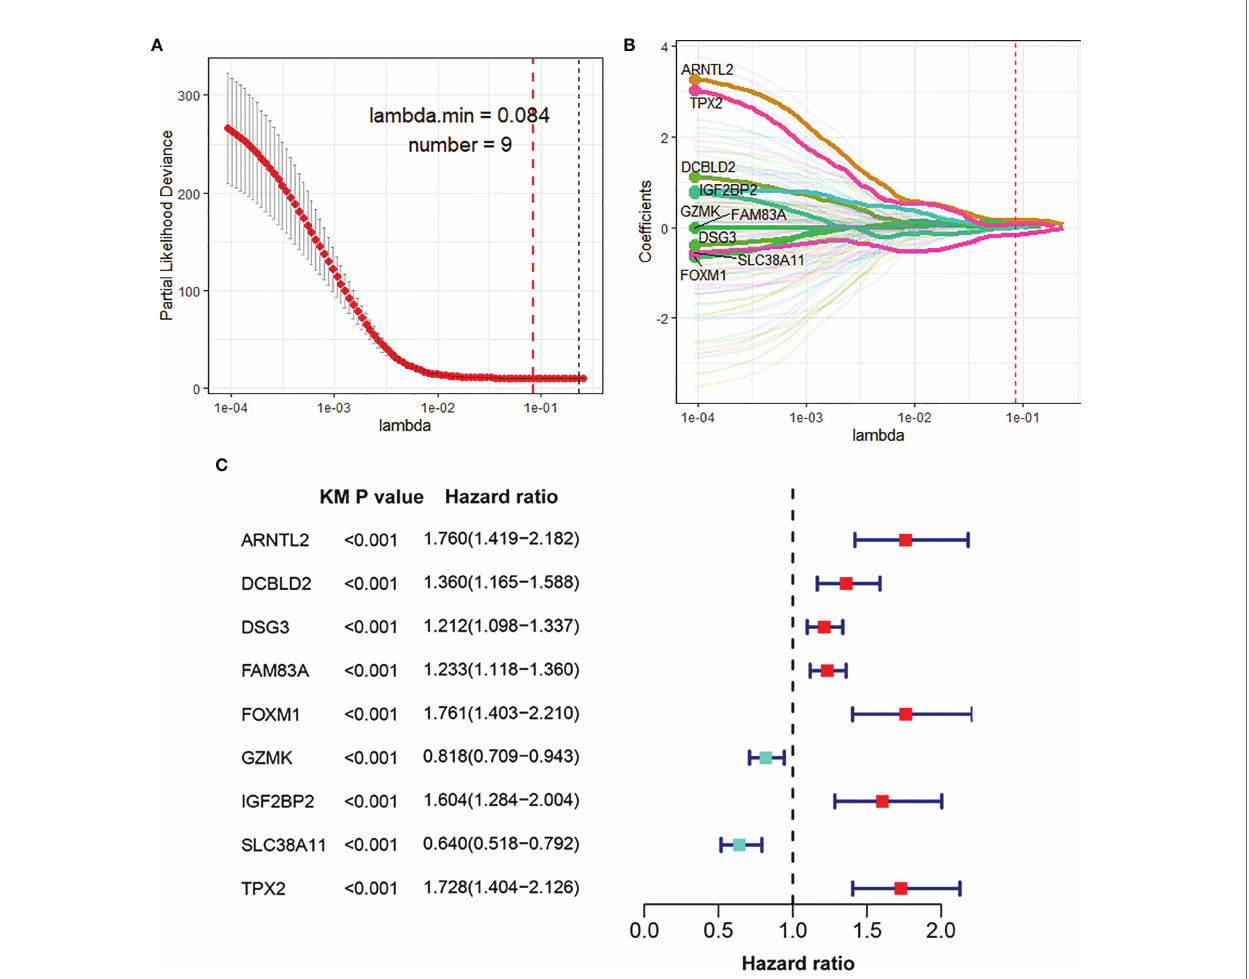
FIGURE 2 | Identi fi cation of nine critical prognosis-associated ODEGs for PDAC. (A, B) LASSO regression analysis identi fi ed nine critical prognosis-associated ODEGs for PDAC. (C) Forest plots to show the results of KM survival analysis of the nine critical prognosis ODEGs. ODEGs, overlapping differentially expressed genes; PDAC, pancreatic ductal adenocarcinoma; KM,